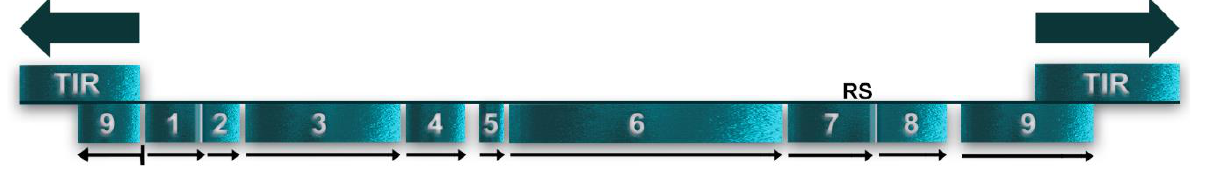
Figure 3. Map of the linear mF plasmid showing significant open reading frames numbered 1 to 9. Arrows indicate the direction of transcription. TIR at the termini indicate terminal inverted repeats. RS indicates the potential recombination site with the mtDNA.